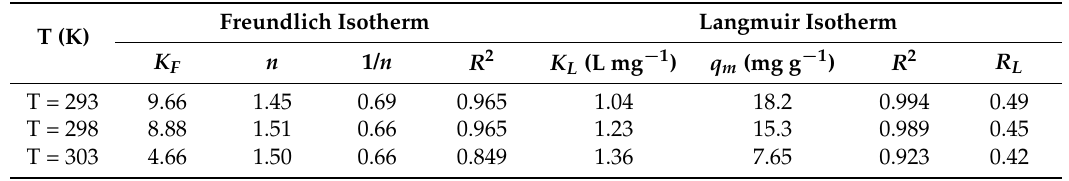
Table 3. Parameters of the isotherms for the adsorption of Sb (III) on ox-xGnP. T (K)